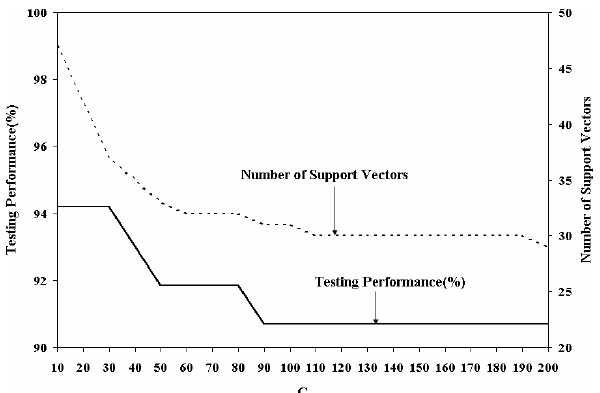
Figure 10. Variation of Testing Performance (%) and Number of Support Vectors with C Fig. 10. Variation of Testing Performance (%) and Number of values for MODEL I using radial basis function kernel. Support Vectors with C values for MODEL I using radial basis function kernel.